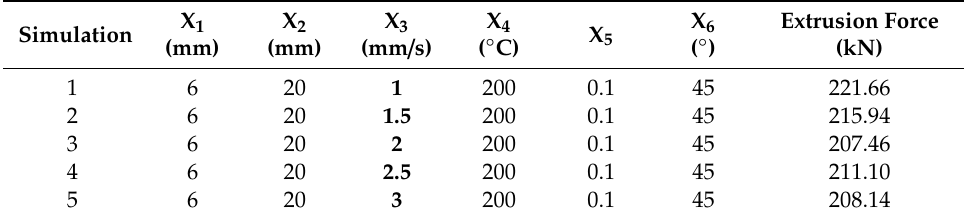
Table 8. Variables combination by varying X 3 (ram speed).